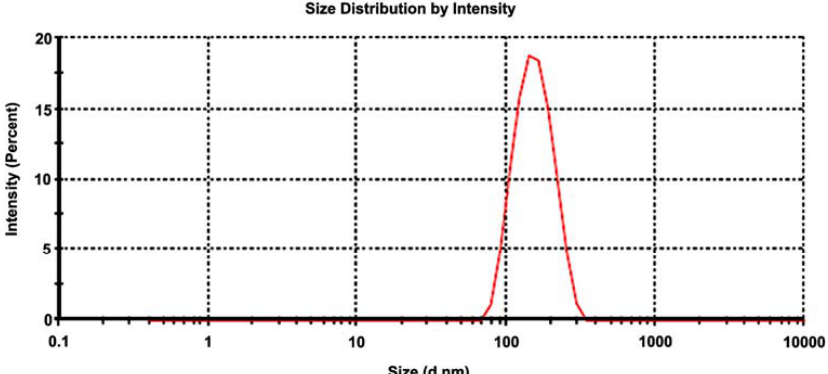
Figure 3. Particle size distribution of HAp nanopowder.